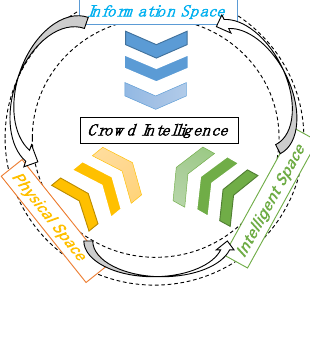
Figure 1. Crowd intelligence in crowd